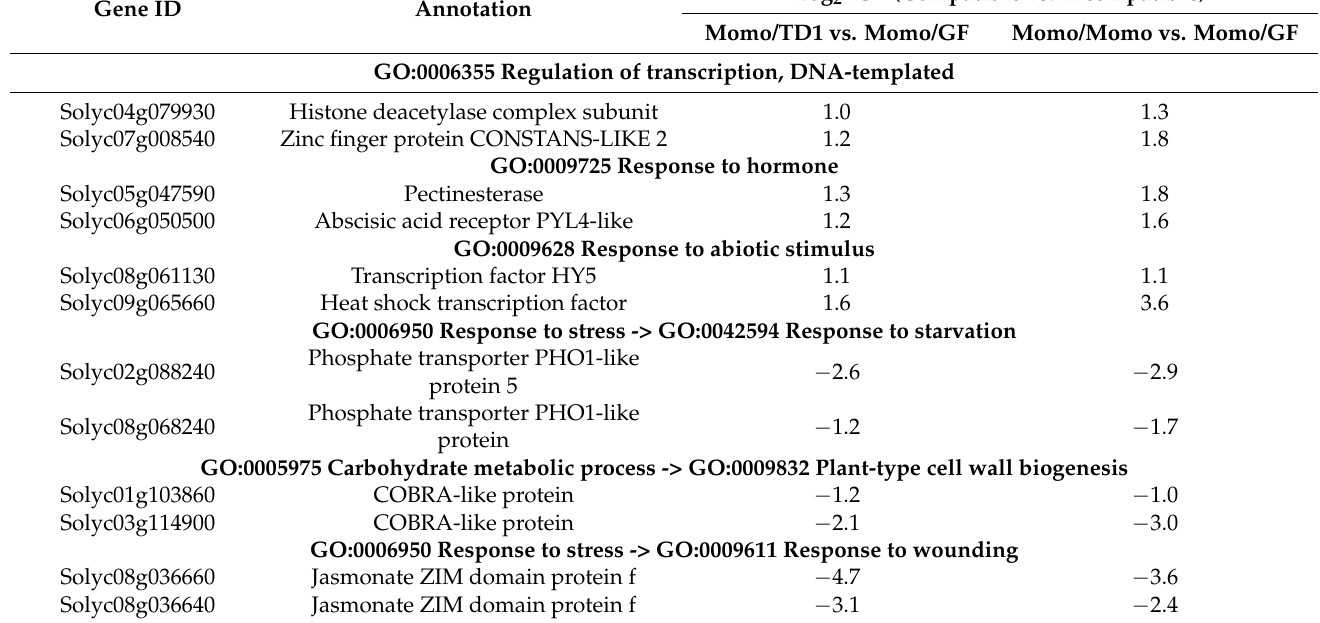
Table 2. List of differentially expressed genes with potential significance to identify compatible grafts [Momotaro (Momo)/TTM-079 (TD1) and Momo/Momo] vs. incompatible [Momo/green force (GF)]